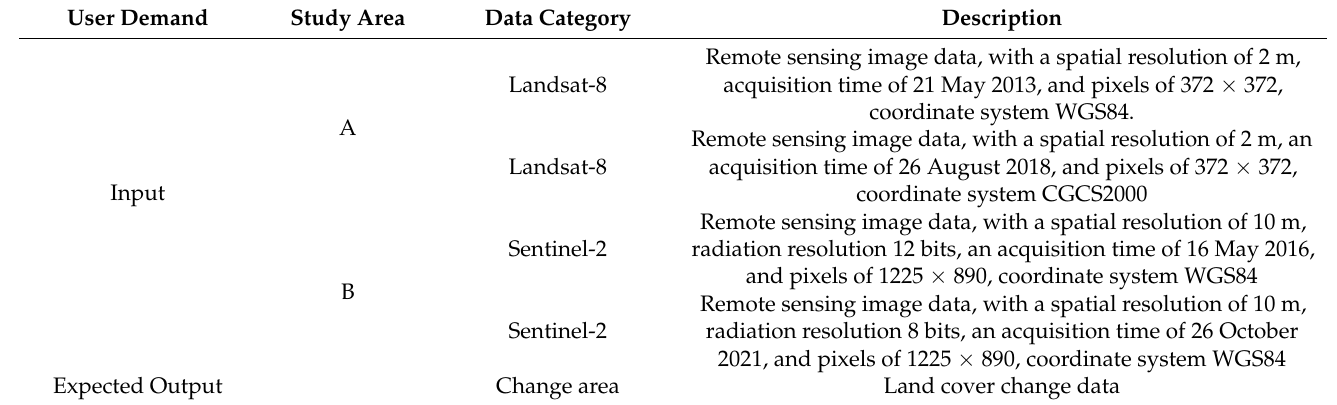
Table 2. A description of user demand and information on images from different study areas.